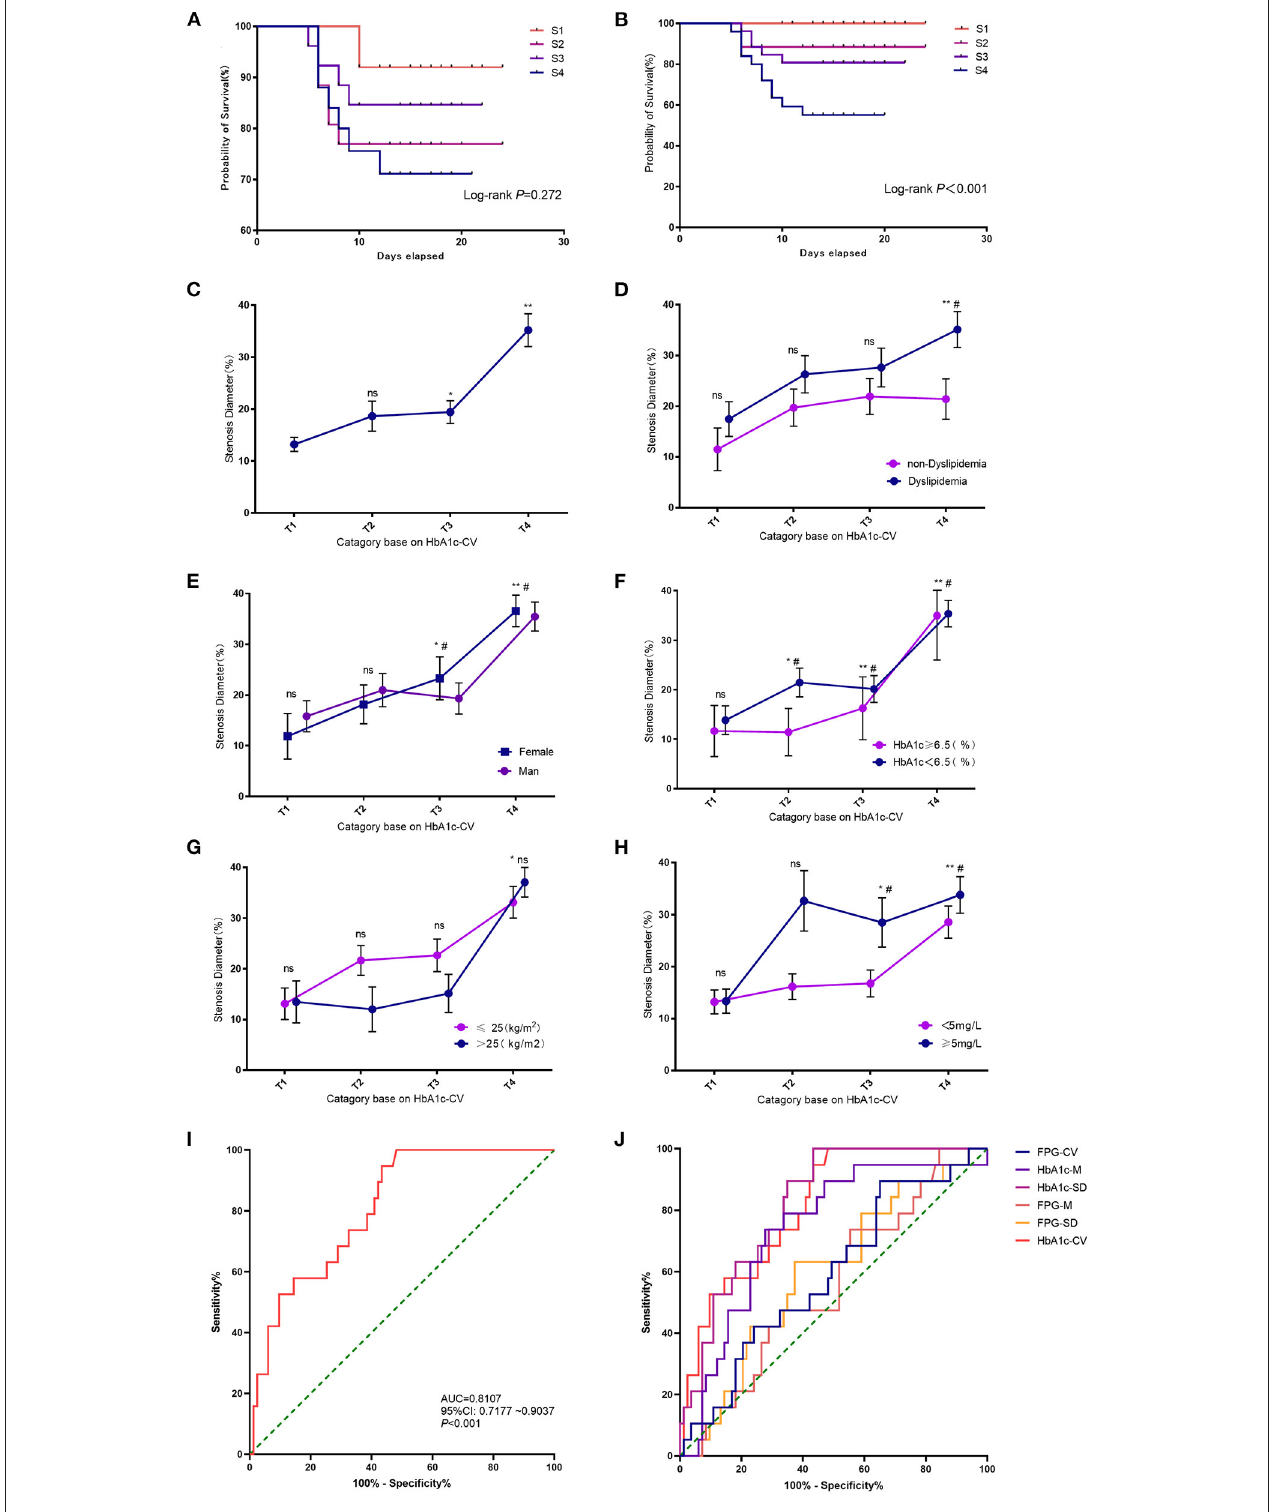
FIGURE 3 | Effects of FPG and HbA1c on the DES-ISR. (A) Survival plot analysis between FPG-CV and the rate of DES-ISR. (B) Survival plot analysis between HbA1c and the rate of DES-ISR. (C) The rate of DES-ISR in the groups with different HbA1c-CV levels. (D) The rate of DES-ISR in patients with different HbA1c-CV levels